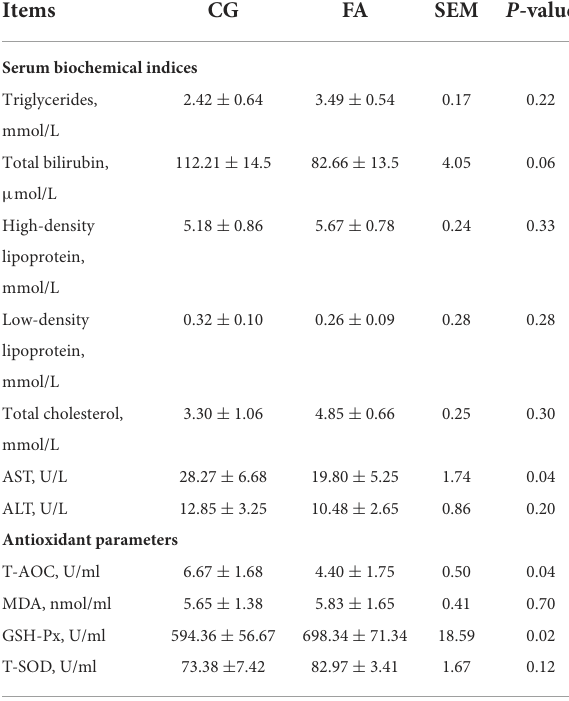
TABLE 3 Serum biochemical indices and antioxidant